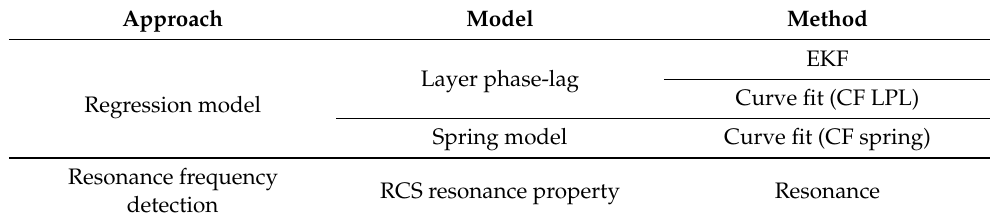
Table 1. Summation of methods experimentally tested.